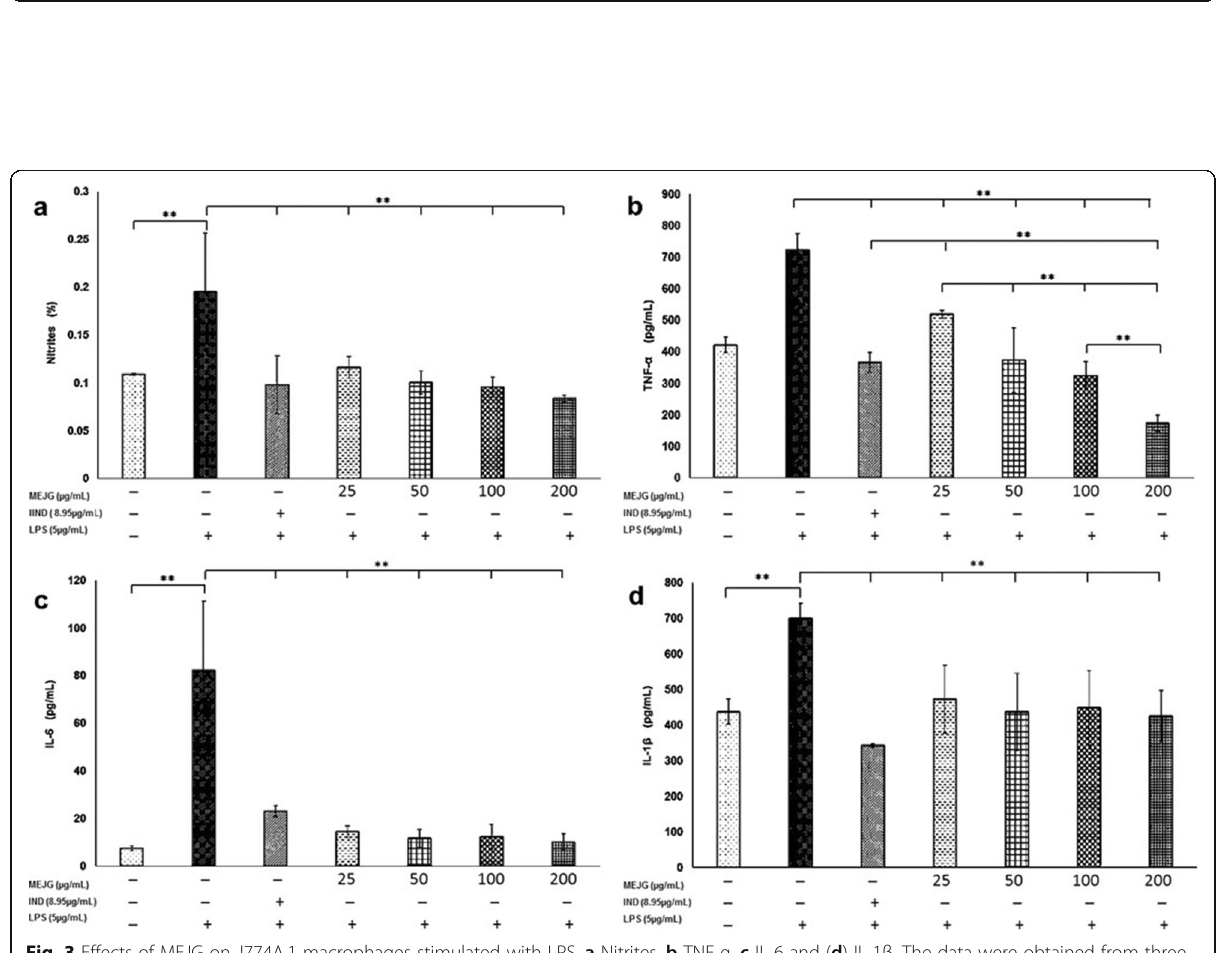
Fig. 3 Effects of MEJG on J774A.1 macrophages stimulated with LPS. a Nitrites, b TNF- α , c IL-6 and ( d ) IL-1 β . The data were obtained from three independent experiments and are expressed as the means ± SD ** p < 0.01 (n =